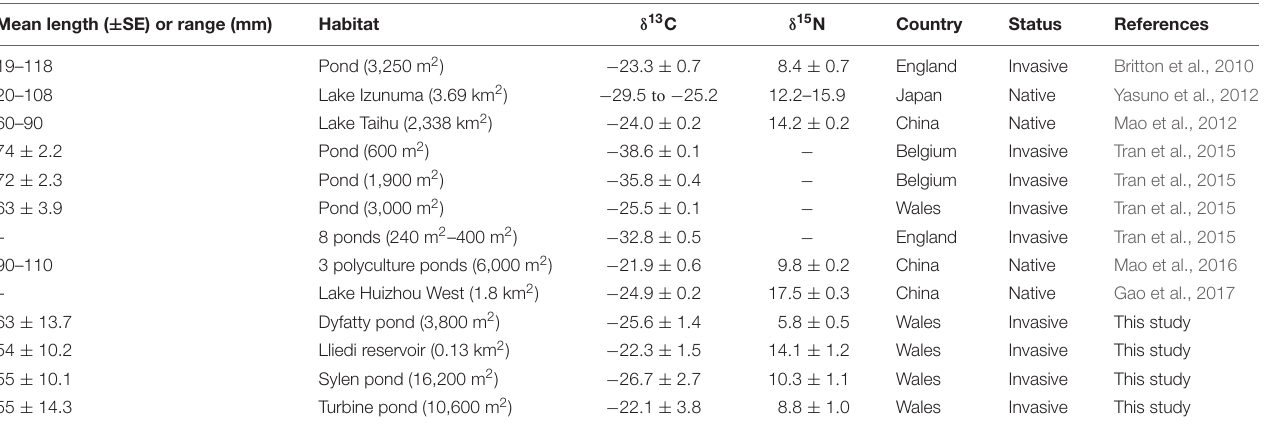
FIGURE 5 | Biplot of δ 13 C vs. δ 15 N of topmouth gudgeon (95% confidence ellipses) across study sites. TABLE 3 | Comparison of isotope values for topmouth gudgeon across locations. Mean length ( ± SE) or range (mm) Habitat δ 13 C δ 15